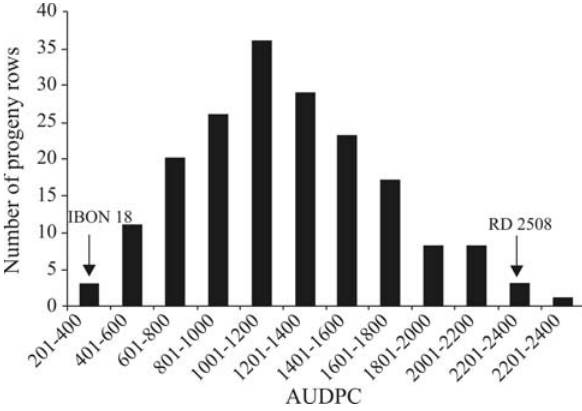
Figure 1 - Distribution of AUDPC of F 3 lines of the cross resistant (IBON 18) x susceptible (RD 2508) for spot blotch severity in barley.